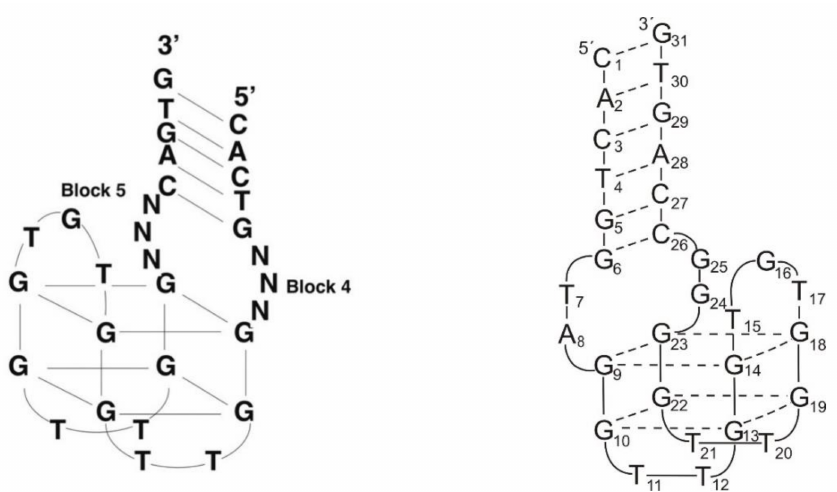
Figure 3. The proposed structure of quadruplex–duplex conjugates selected by in silico screening [53] ( left ) and 31TBA ( right ). The N corresponds to A, C, G, or T. Reproduced by permission from the Nucleic Acids Research and Oxford University